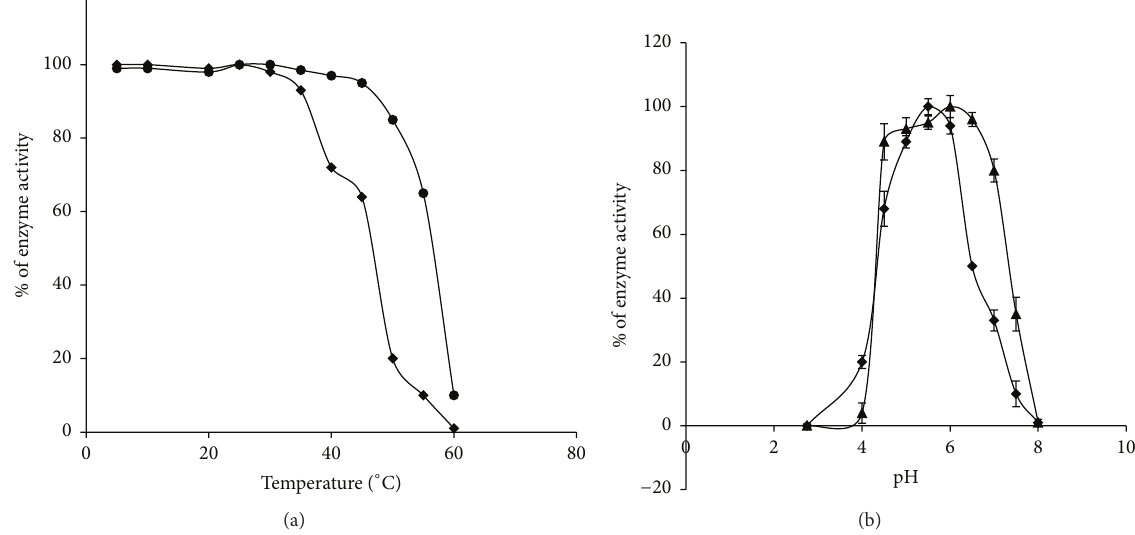
Figure 4: The temperature tolerance and optimum pH of intra- and extracellular sucrase: (a) the intra- and extracellular enzymes were preincubated for 30 min at different temperature (4–60 ∘ C) prior to estimating the enzyme activity under standard assay condition in 50mM sodium acetate buffer at pH 6.0 and pH 5.5, respectively. The enzyme activities of intracellular (- X -) and extracellular sucrase (- e -) were plotted as percentage of maximum activity (100%) at different temperature. (b) The pH optimum was measured by performing activity assay at different pH at a range of 02.75–8.0 as mentioned in Materials and Methods. The intracellular (- 󳵳 -) and extracellular (- X -) sucrase activities were plotted as a percentage of activity versus pH, with maximum activity being 100%. Each point represents the mean of three different experiments.